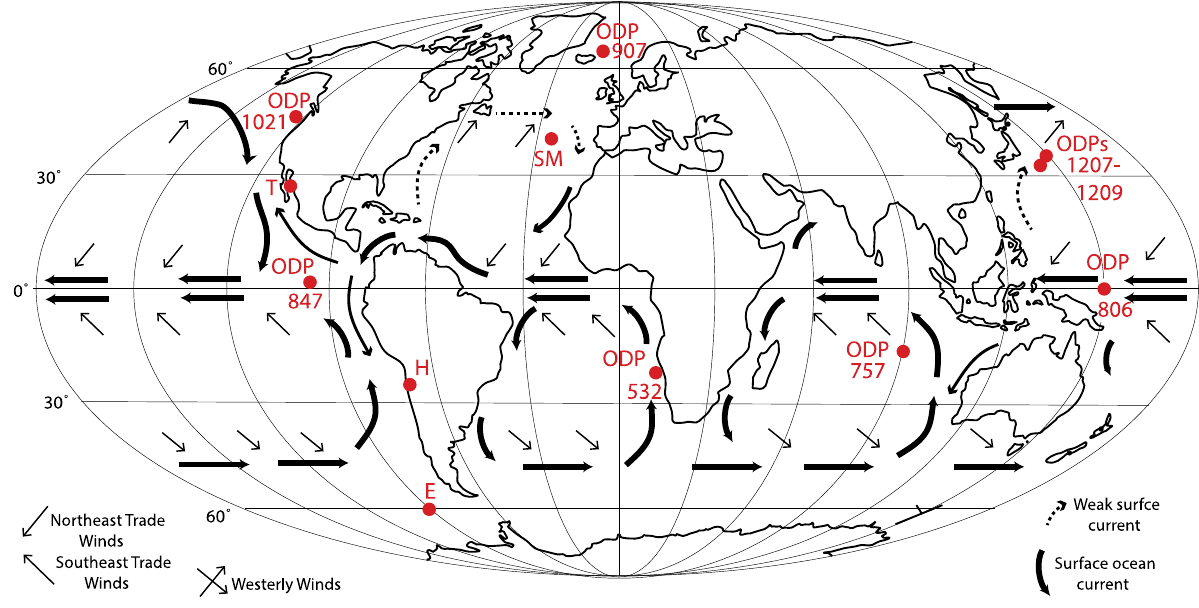
Figure 10. Global geography for the Pliocene Period, showing projected atmospheric circulation and ocean currents as well as the locations of many key study sites referenced in this review. Weakened surface currents shown by a dashed line. Map abbreviations: SM = Santa Marina Island (Azores archipelago), T = Tiombó conglomerate (Gulf of California), ODP = Ocean Drilling Project sites, H = Caletas Hornitos (northern Chile), and E = Eltanin impact site (off the southern tip of South America).